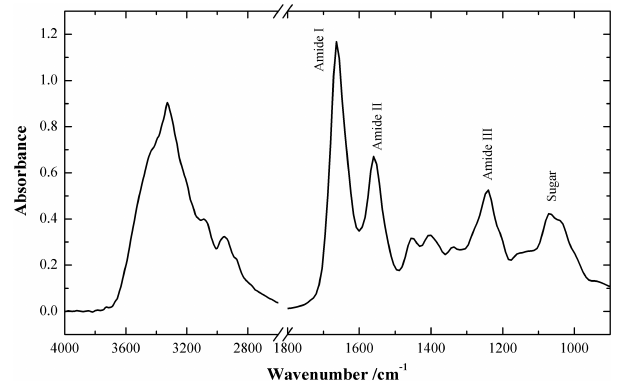
Fig. 1. An IR spectrum from the FTIRI image of the healthy articular cartilage. Two characteristic peaks of collagen were assigned to amides I and II band, and sugar (1072 cm (cid:1) 1 Þ band was attributed to PG. The spectral ranges for amides I, II, III and sugar are 1700 – 1600 cm (cid:1) 1 , 1600 – 1500 cm (cid:1) 1 , 1300 – 1200 cm (cid:1) 1 , and 1125 – 960 cm (cid:1) 1 , respectively.